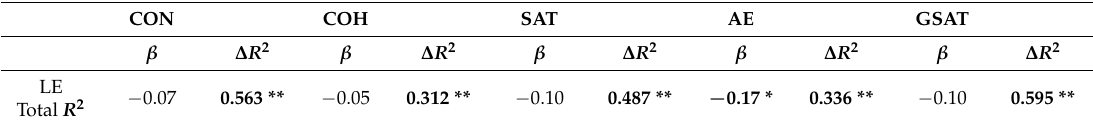
Table 4. Hierarchical regression analysis in which the quality of the partnership and its components were the explained variables. CON COH